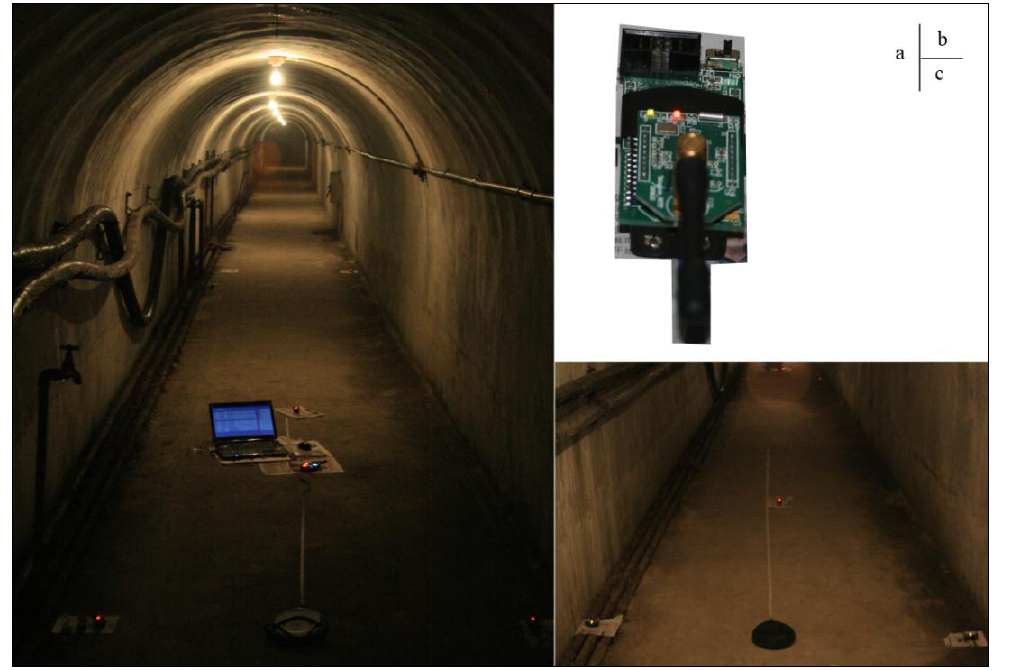
Figure 12. The deployment of positioning system in a underground